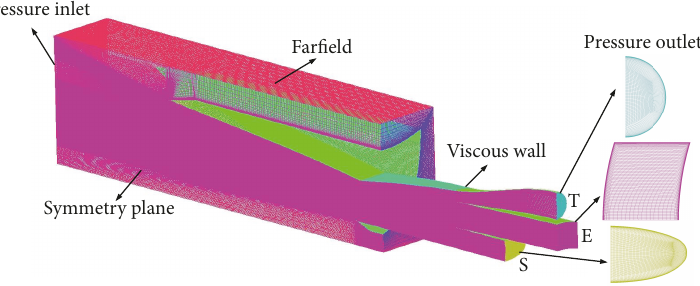
Figure 4: Structured grid for the tri-duct inlet.